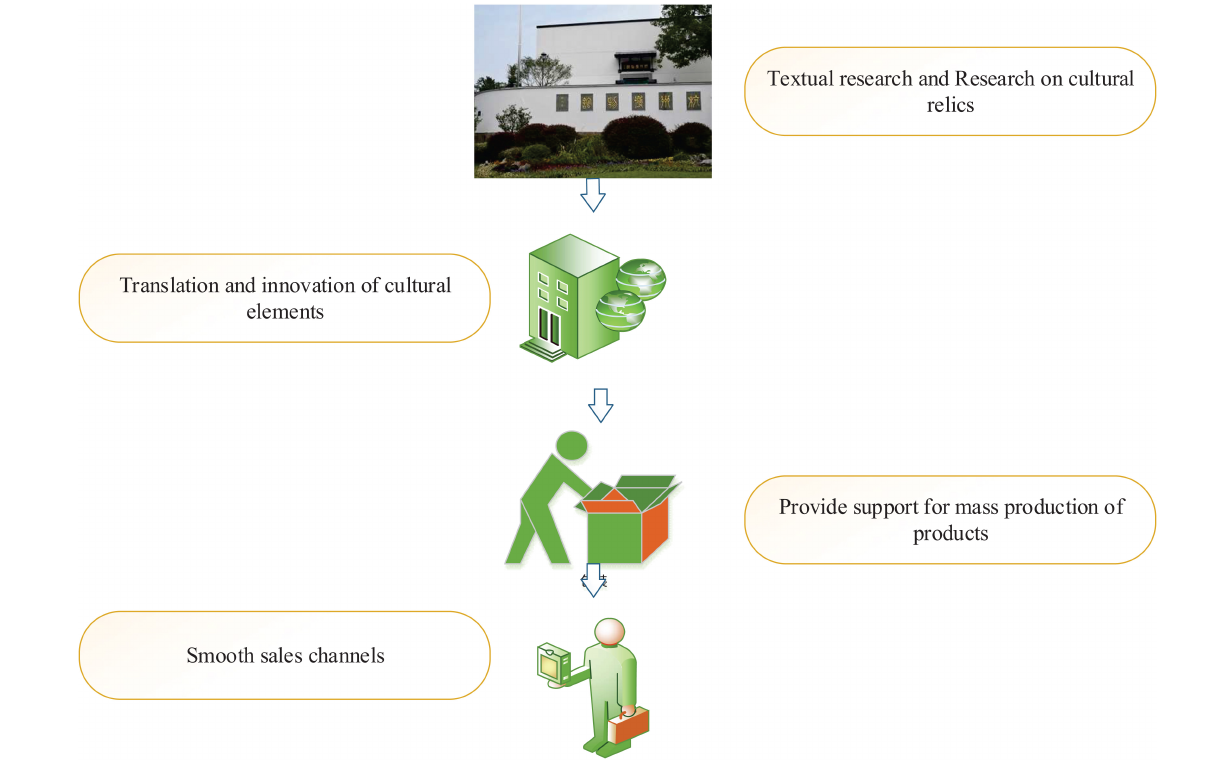
FIGURE 1 | Operation process of museum cultural and creative industry